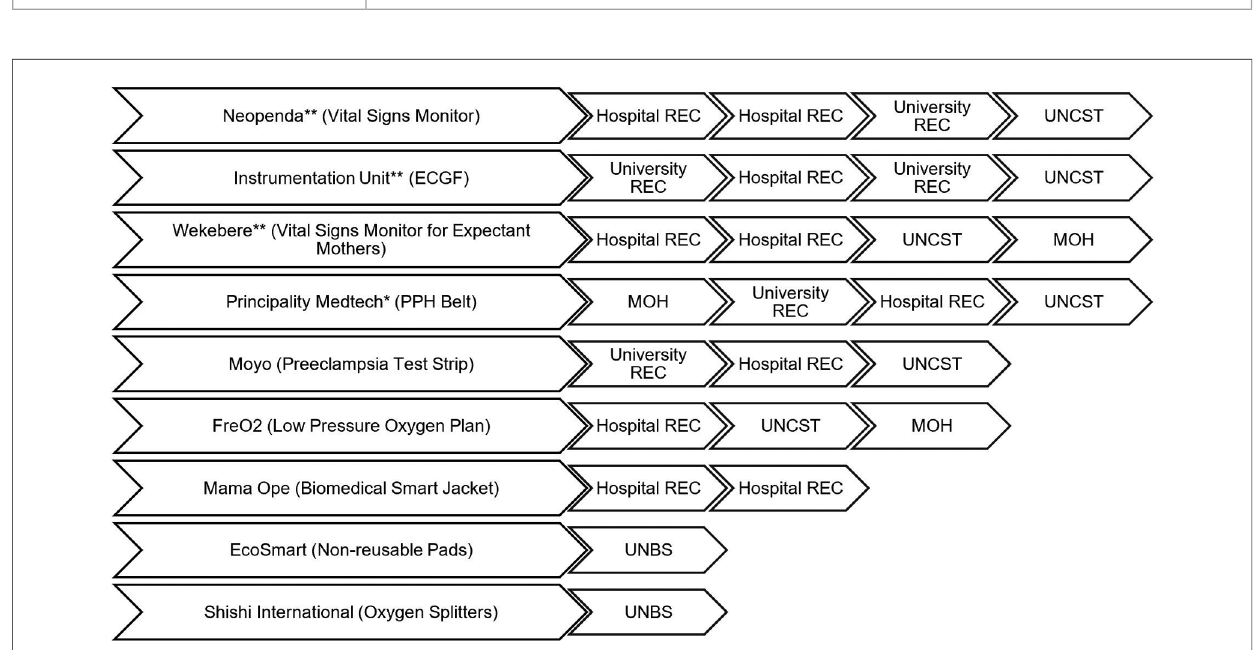
FIGURE 1 Flow chart of approvals that innovators received from regulatory bodies by company. Multiple boxes of RECs of the same kind (e.g. from hospital REC to hospital REC for one team) means that the team went to two different RECs. (*) The innovator went to the NDA fi rst and was told NDA does not carry out IMD regulation. (**) obtained waivers from NDA stating that they lack the capacity to assess IMDs in terms of safety and performance, and recommended the entity proceeds with clinical trials provided they have approval from a REC and